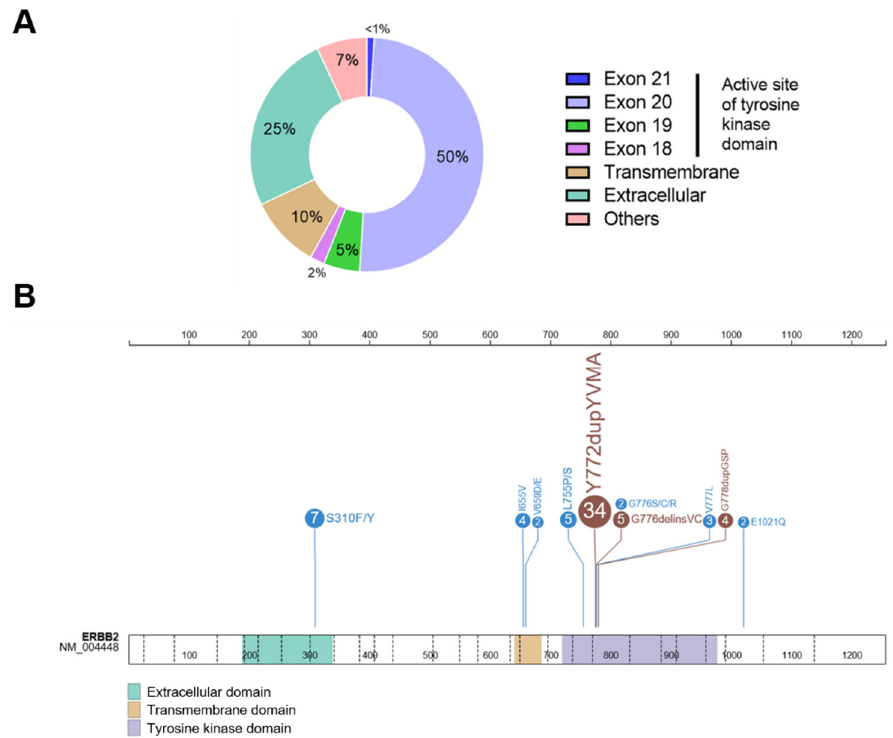
Figure 2. Distribution of the most frequent HER2 mutations in NSCLC. ( A ). Plot displaying the protein domain and exon location of HER2 mutations in NSCLC. ( B ). Lolliplot representation of HER2 protein with frequency and location of the main HER2 mutations in NSCLC. Numbers in circles are %. Brown circles are in-frame mutations. Blue circles are missense mutations. The data on frequency are from Robichaux et al., Fang et al., Zhou et al., and Li et al. [22,41,56,70].